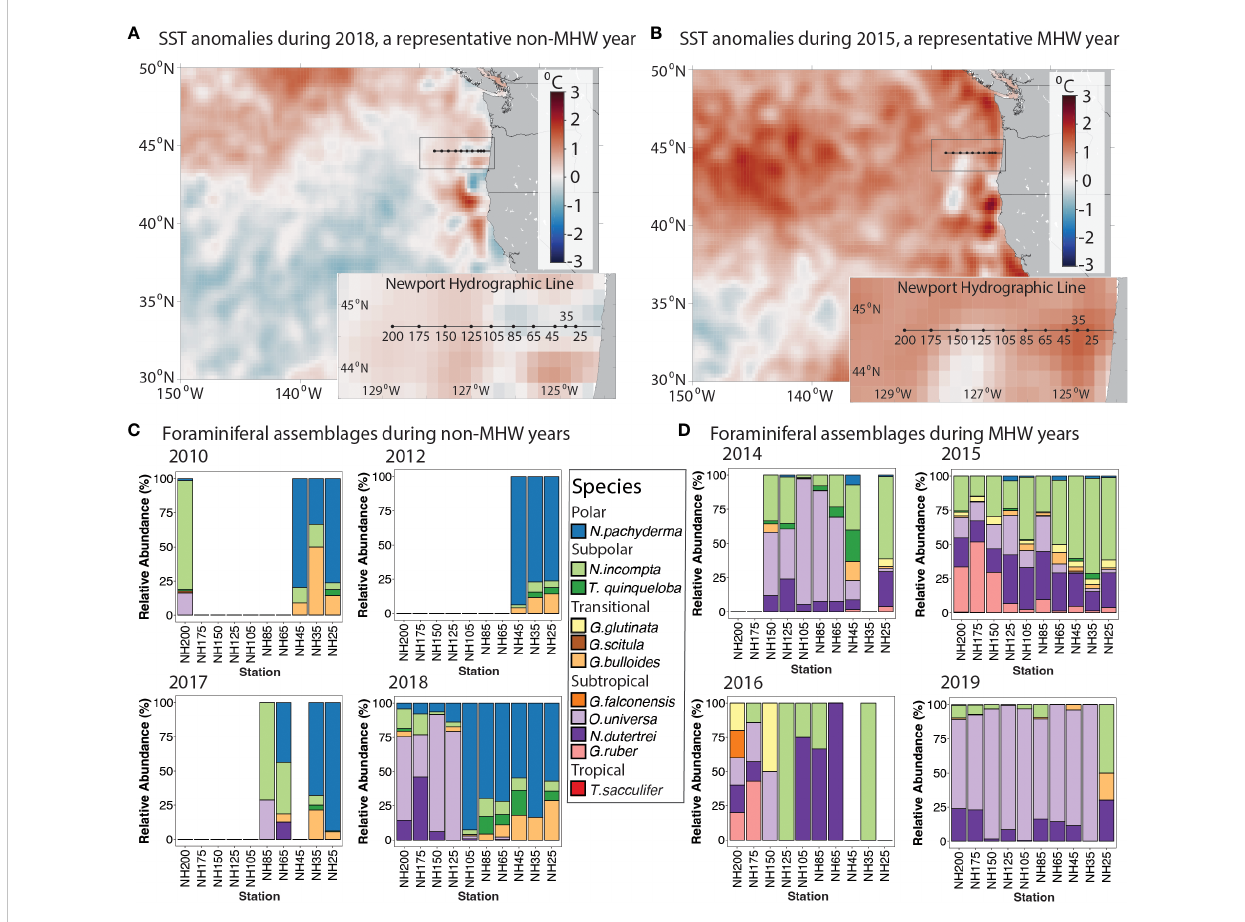
FIGURE 3 Planktonic foraminifera relative abundances in MHW and non-MHW years. (A, B) Time-averaged sea surface temperature anomalies for (A) 23 August - 21 September 2018, a 30-day period during a representative non-MHW year, and (B) 12 September - 11 October 2015, a 30-day period during a representative MHW year. Anomalies are calculated relative to a 39-year climatological estimate (from OISST, see Methods). (C, D) Foraminifera relative abundance (%) for all available NH Line stations from fall cruises, grouped by years (C) without a MHW and (D) with a MHW. Species are grouped by bioprovince following Kucera (2007). Foraminifera samples were collected in the upper 100 m of the water column. Station name denotes distance in nautical miles offshore, e.g., NH200 is 200 nautical miles